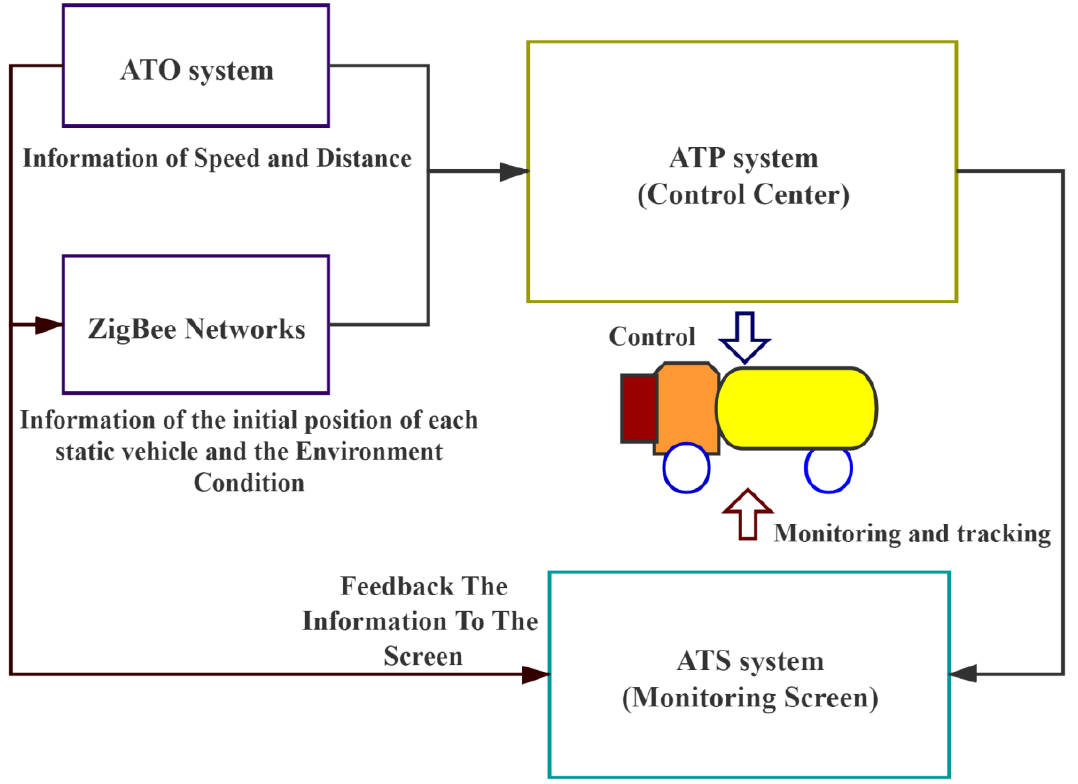
Figure 2. Concept design of the integrated system.